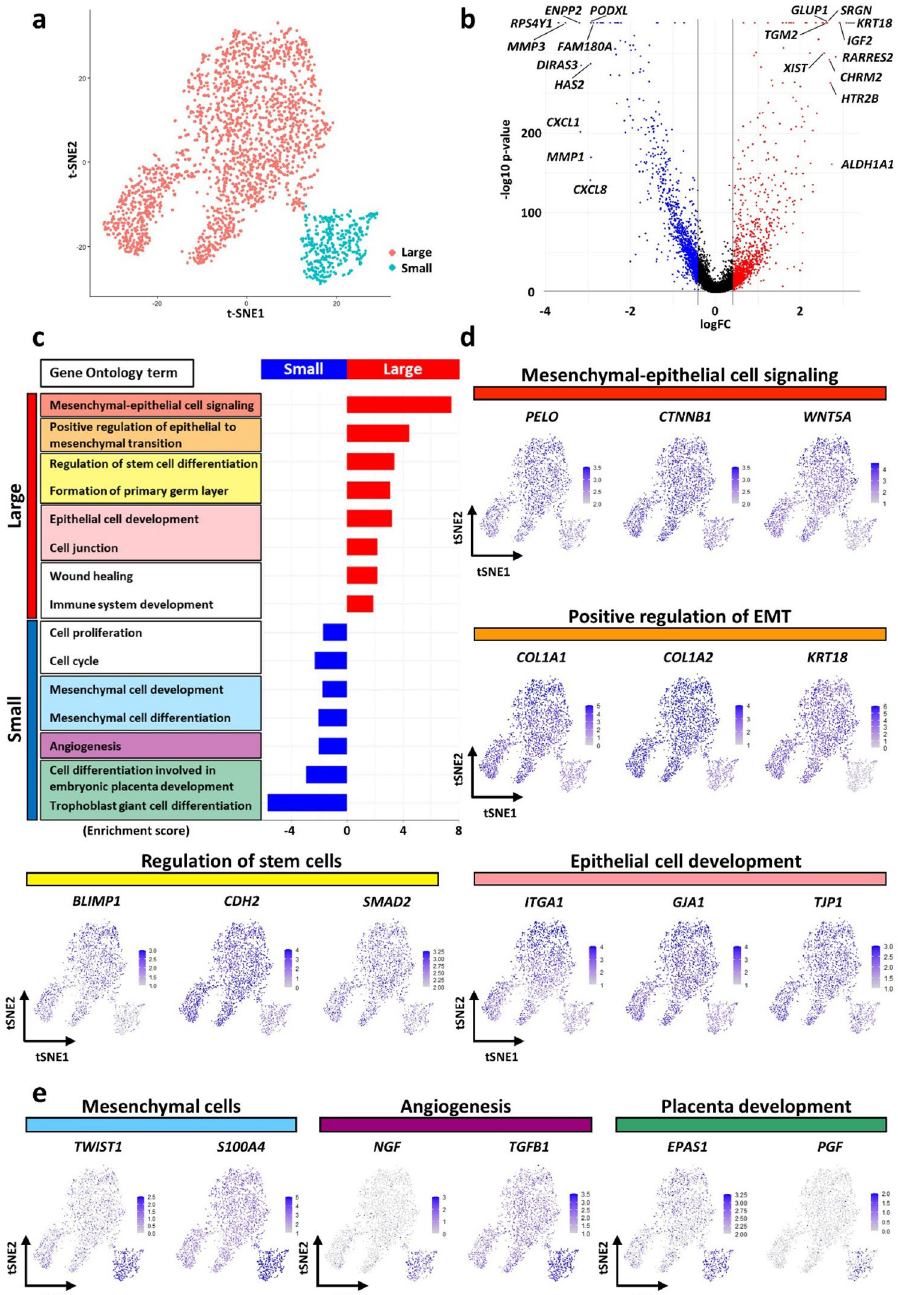
Figure 3. Subpopulation analysis in hAM-Muse cells by scRNA-seq. ( a ) t-SNE plot of the large (red) and small (blue) subpopulations in hAM-Muse cells. ( b ) Volcano plot displaying gene expression levels in the large subpopulation compared with the small subpopulation. Significantly differentially expressed genes were defined as those with a fold-change > 1.5 times or < 0.67 times in the large subpopulation compared with the small subpopulation, with p < 0.05. Upregulated genes are shown in red, downregulated genes are shown in blue, and the black lines represent the boundary for identification of upregulated or downregulated genes based on the p -value and fold-change. Top 10 differentially expressed genes in the large and small subpopulations are shown. ( c ) GO analysis; upregulated genes in the large (red) and small subpopulation (blue) are listed. Enrichment score of each term is shown. ( d ) t-SNE plots showing the expression levels of representative genes related to M-E cell signaling, positive regulation of EMT, regulation of stem cells, and epithelial cell development. Each term was upregulated in the large subpopulation. ( e ) t-SNE plots showing the expression levels of representative genes related to angiogenesis, mesenchymal cells, and placenta development. Each term was upregulated in the small